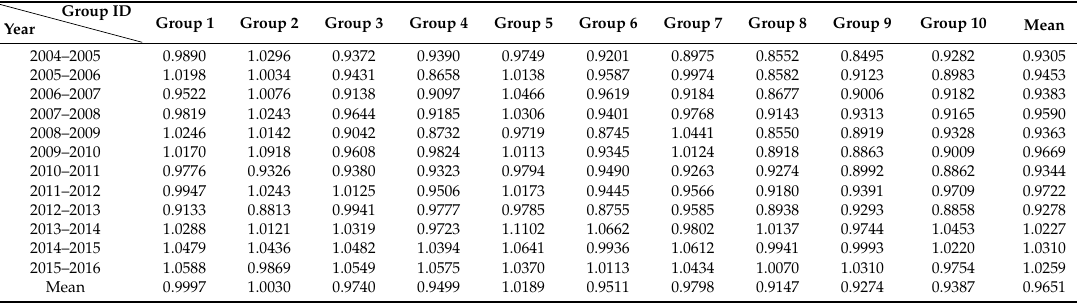
Table 7. Changes in the meta-frontier Malmquist total factor productivity index (MMPI) in ten major city groups under PM 2.5 constrictions.